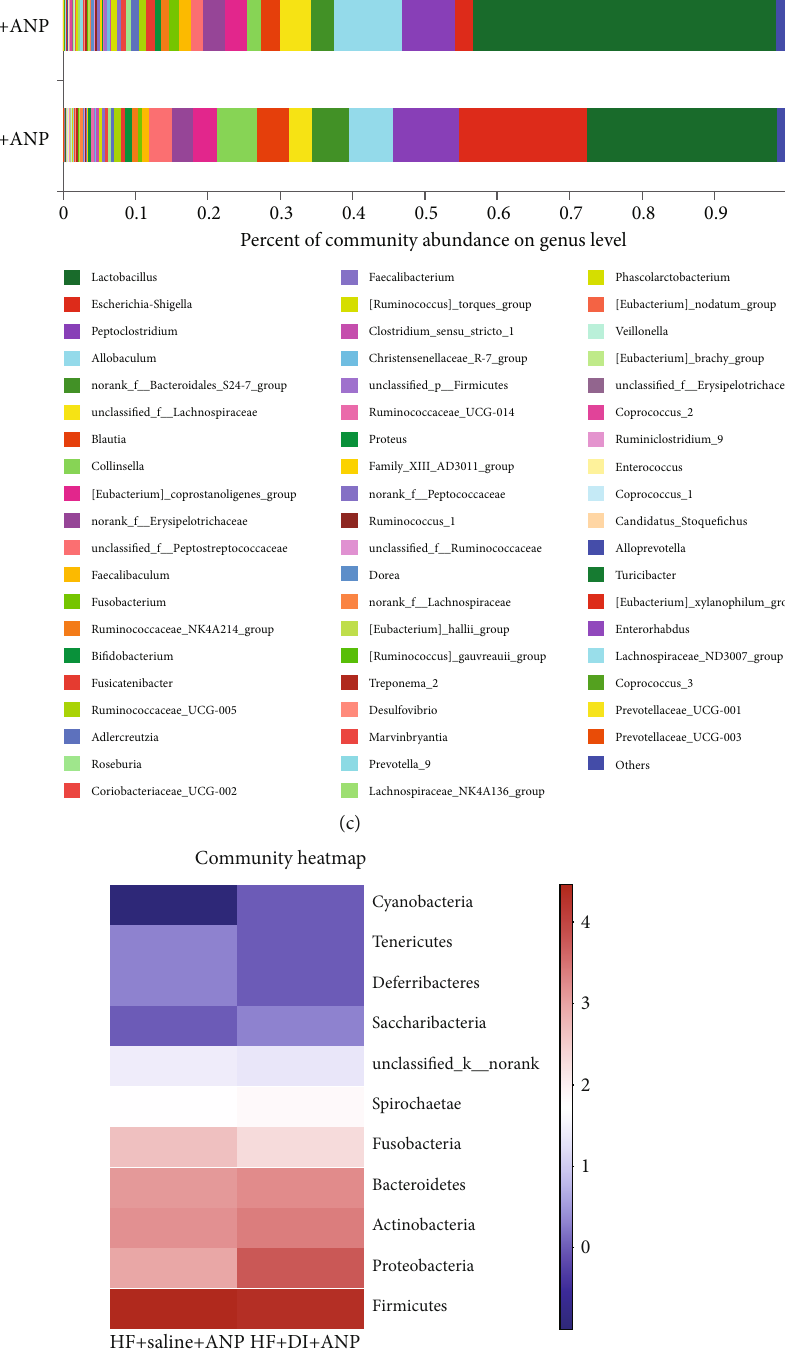
Figure 8: E ff ects of dithizone on microbiota diversity in rats on high-fat diet followed by retrograde sodium taurocholate infusion. (a) Estimators of intestinal microbiota α -diversity in rats treated with dithizone or saline. (b) PCA of microbial β -diversity in rats treated with dithizone or saline. (c) Relative abundance of intestinal microbial genera in rats treated with dithizone or saline. (d) Heatmap of relative abundance of bacterial phyla in intestinal microbiota of rats treated with dithizone or saline. ∗ p < 0 : 05 , ∗∗ p < 0 : 01 , ∗∗∗ p < 0 : 001 , Student ’ s t -test. n = 8 for each